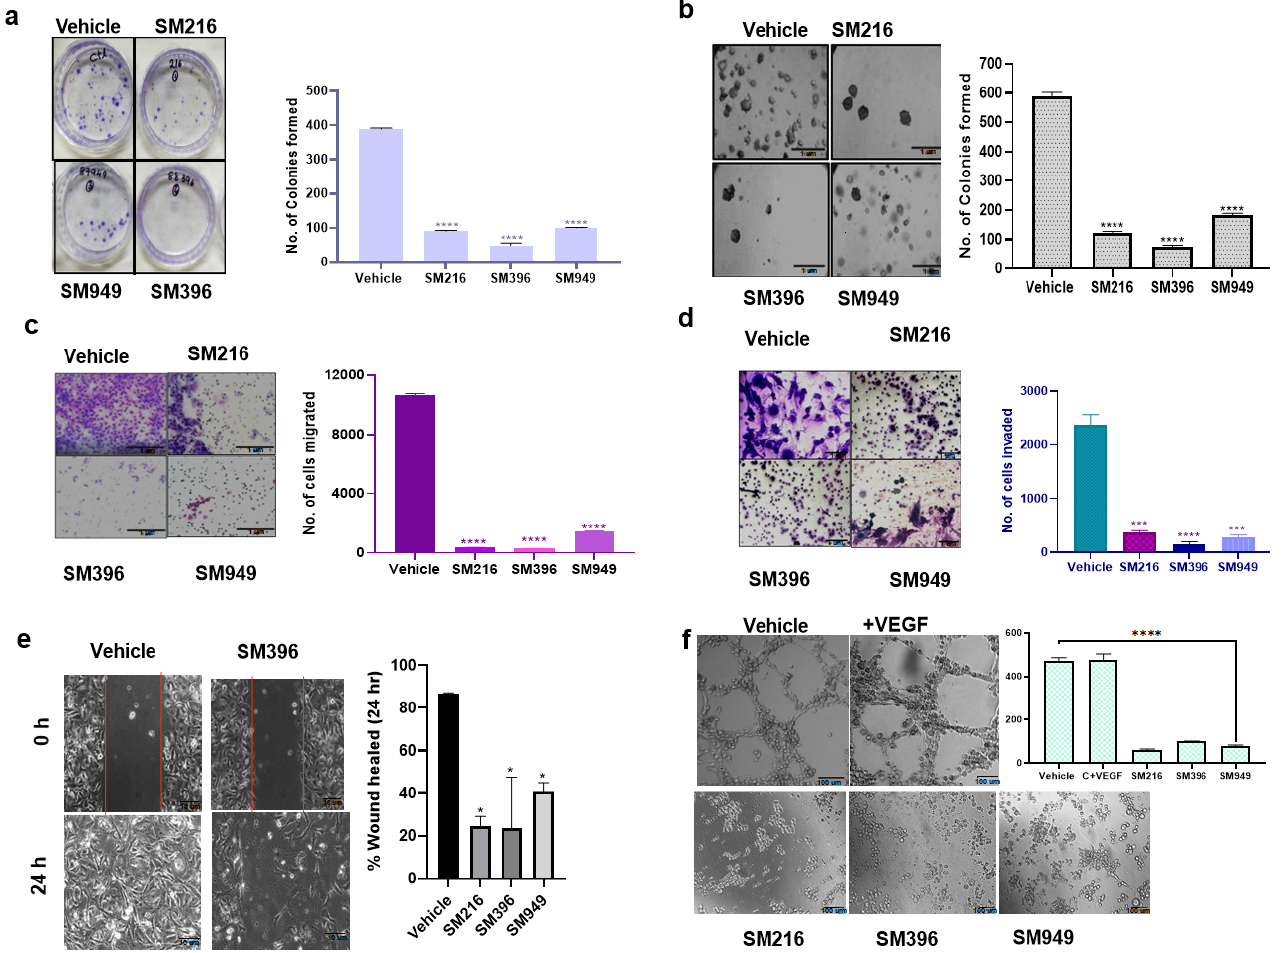
Figure 5. SM216, SM396, and SM949 effectively inhibited the tumorigenic potential of MDA-MB-231 cells. ( a ) Clonogenic assay showing the reduced number of colonies formed in MDA-MB-231 cells upon treatment ( n = 2). ( b ) Soft agar assay showing reduced colony formation of MDA-MB-231 cells upon treatment. ( c , d ) Transwell assay showing reduced migration and invasion capabilities of MDA-MB-231 cells upon treatment. ( e ) Wound healing assay showing reduced migration of MDA-MB-231 cells upon treatment. ( f ) Angiogenesis assay showing reduced tube formation of EaHy976 cells upon treatment. (Drug concentrations used SM216: 1.866 μ M, SM396: 2.995 nM, and SM949: 0.1875 μ M). * denotes p ≤ 0.05, *** denotes p ≤ 0.001 and **** denotes p ≤ 0.0001.